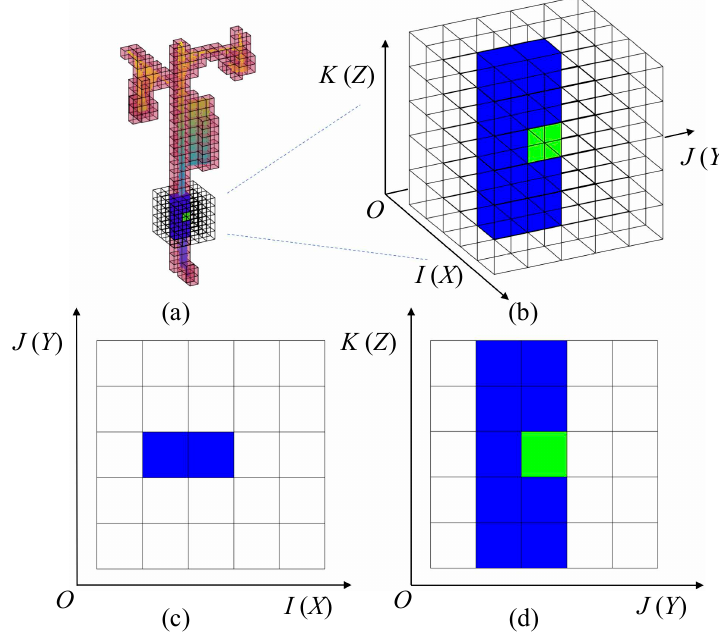
Figure 6. Space structure of PLO voxels. ( a ) PLO voxels; ( b ) Neighborhood voxels; ( c ) Top view of ( b ); ( d ) The side view of ( b